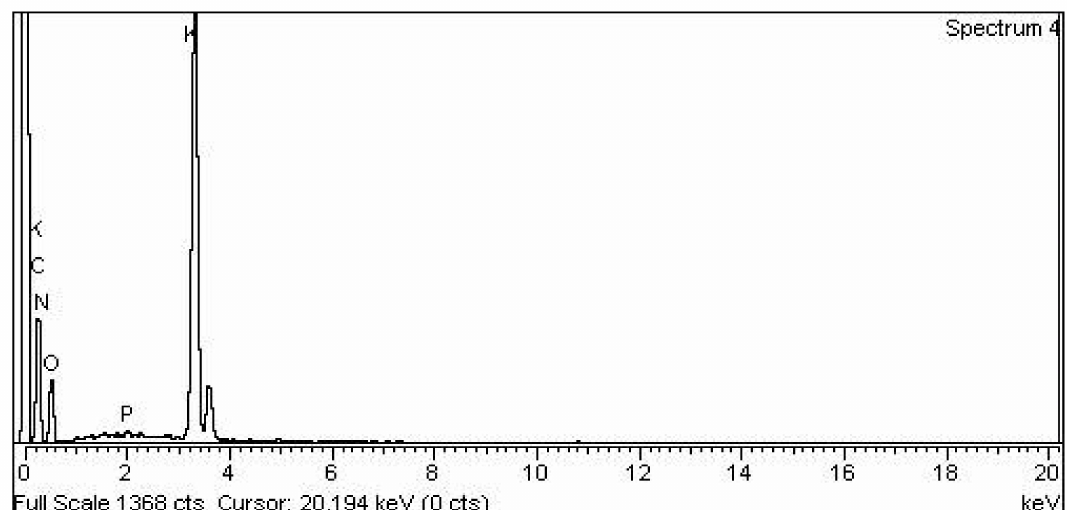
Figure 10. EDX analysis of KPC.